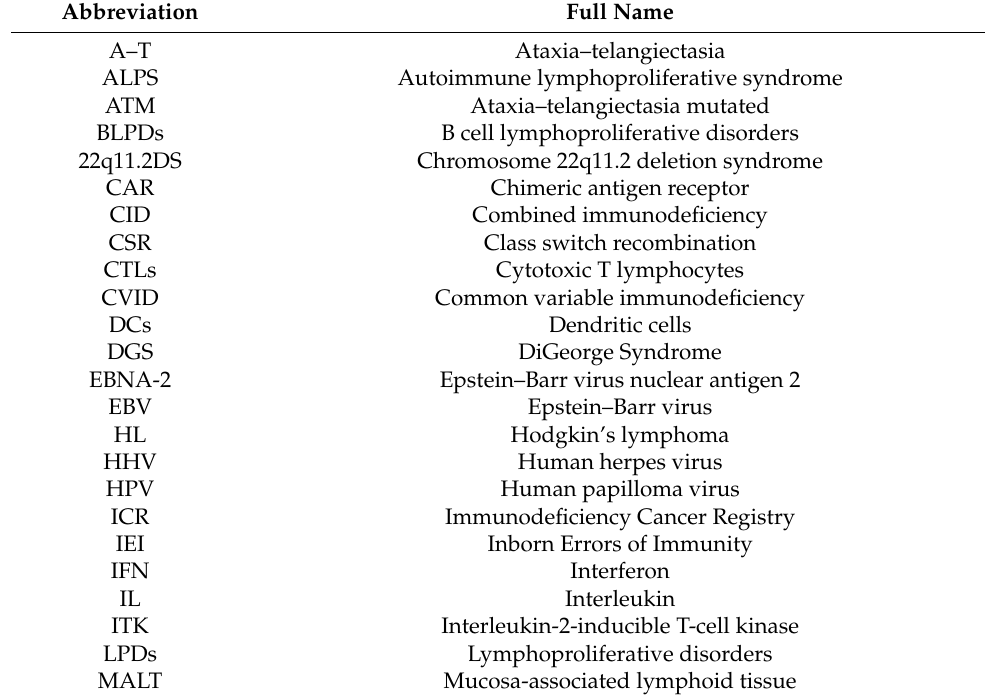
Table 1. Abbreviations used in this